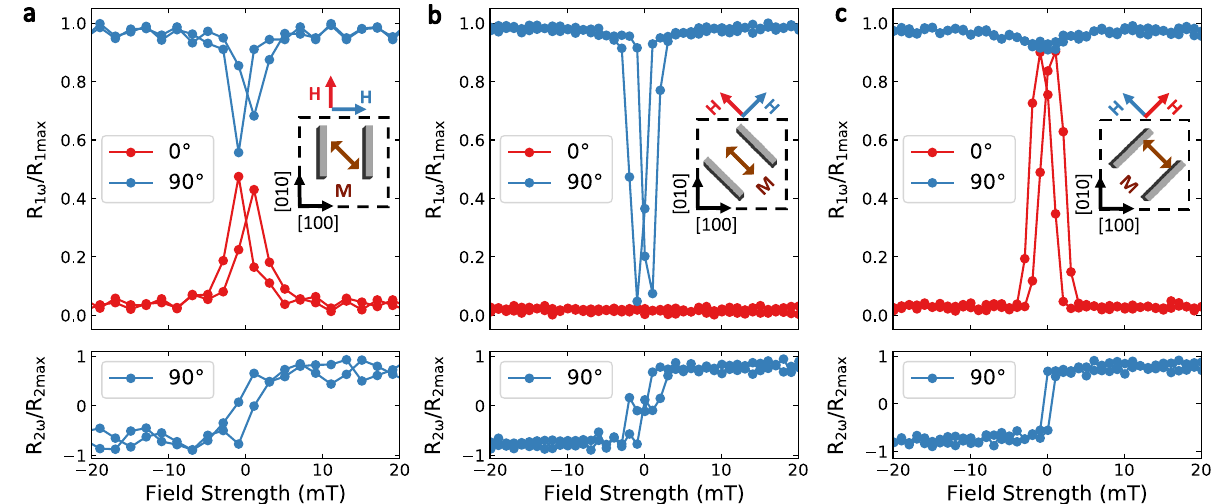
Fig. 3 | Magnetic fi eld dependence of nonlocal measurements. Normalized nonlocalresistancesforthePtwiresalong a [010], b [1 (cid:1) 10],and c [110]axesforawire separationof1 µ m.Ineachpanel,thebluelinecorrespondstoamagnetic- fi eldscan perpendiculartothePtwiresandtheredlinecorrespondstoa fi eldscanparallelto